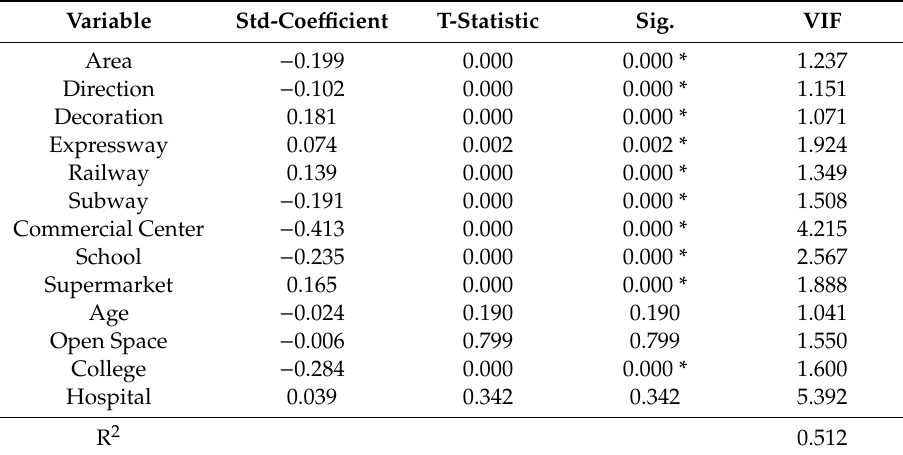
Table 2. Regression result of the ordinary least square (OLS)